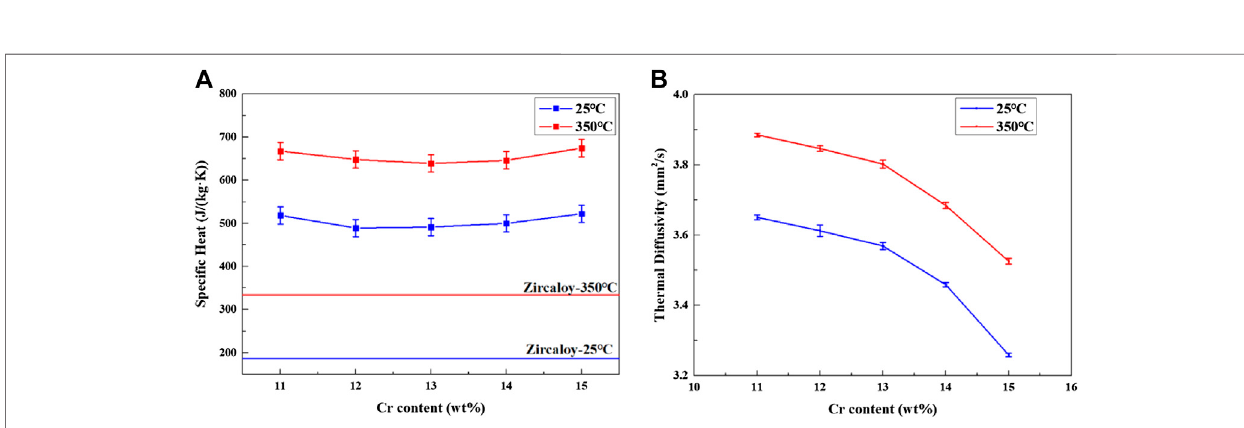
Frontiers in Materials |